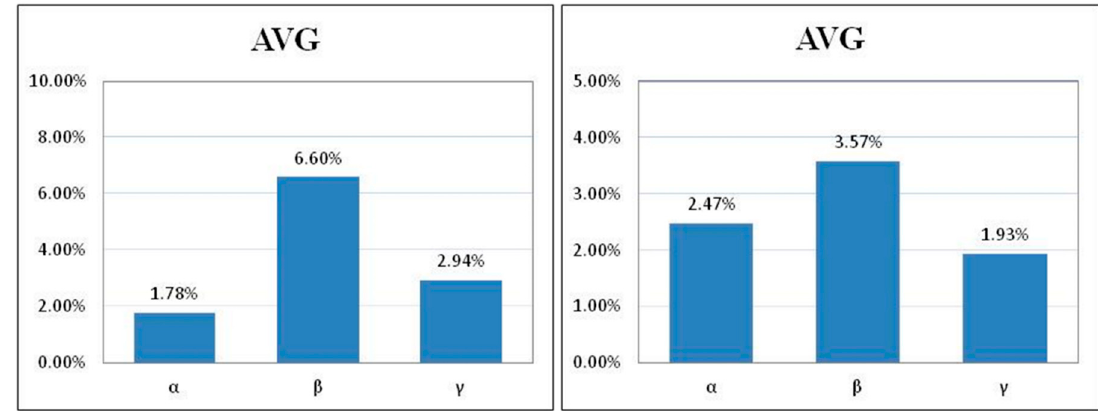
Figure 4. Weighted effect of each factor on the phase purity ( left ) and yield ( right ) of hydrothermally synthesized smectites.